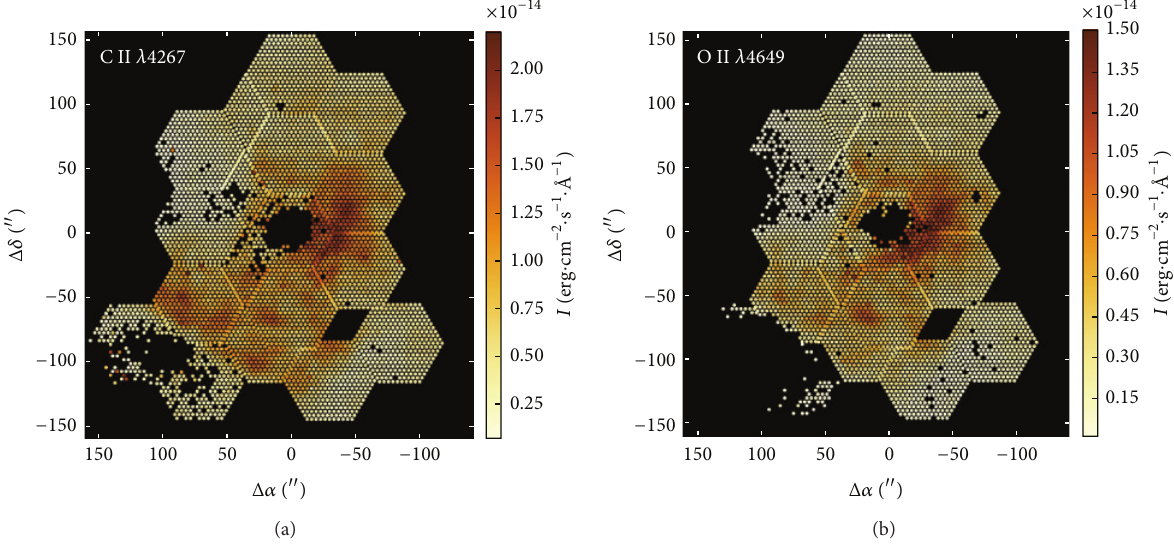
Figure 8: Spatial distribution maps of dereddened fluxes of RLs: (a) C II 4267 ˚A and (b) O II 4649 ˚A. The black areas in the center are contaminated by emission from the Trapezium stars. The coordinates are centered on 𝜃 1 Ori C. The figure has been adapted from [36].